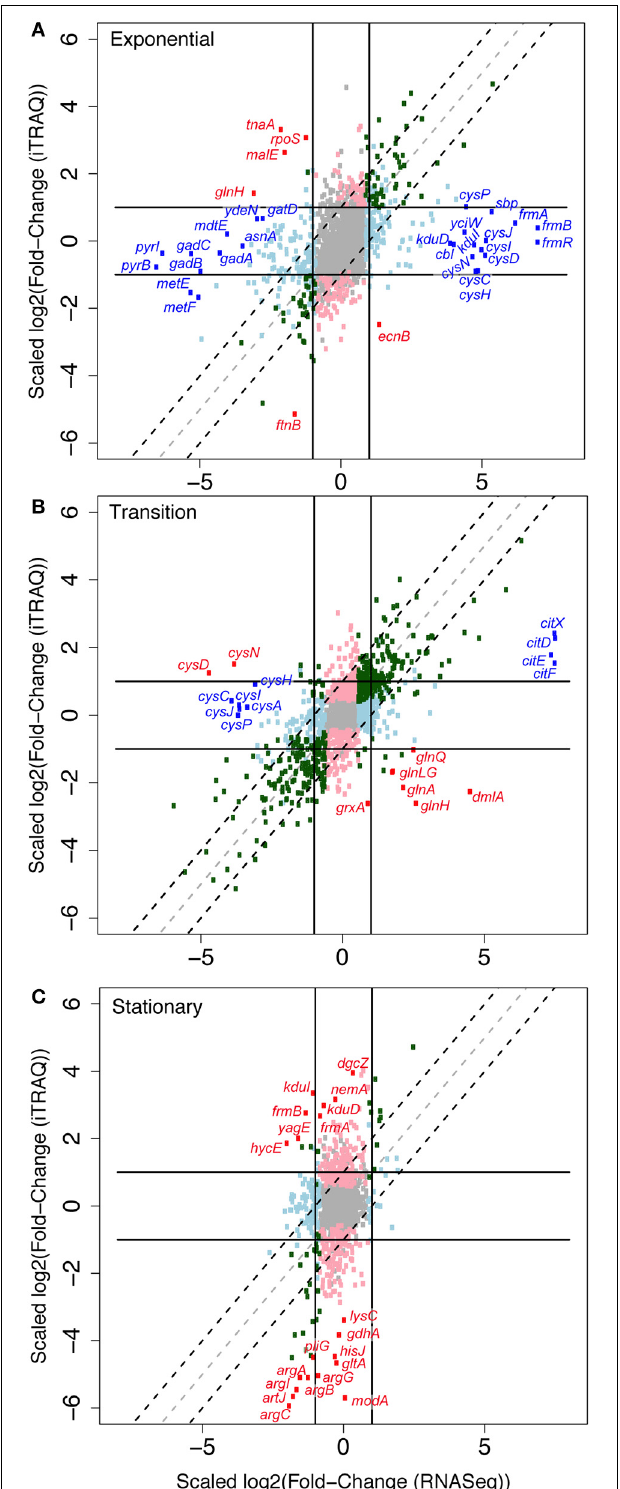
FIGURE 6 | Effects of aromatic inhibitors on protein levels compared to effects on cognate RNA levels. Scatter plot comparing log 2 -fold RNA ratios (x-axis) to log 2 -fold protein ratios (y-axis) of GLBRCE1 genes and gene